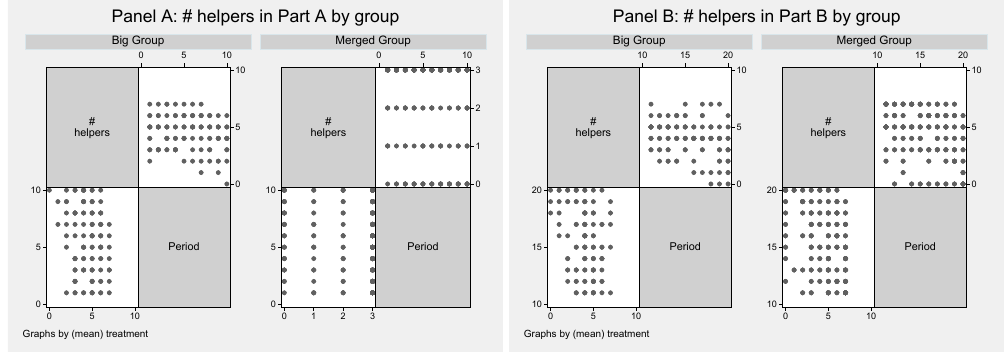
Figure A4. Number of helpers by group in Part A and Part B. Panel B: Average group payoff in Part B by group